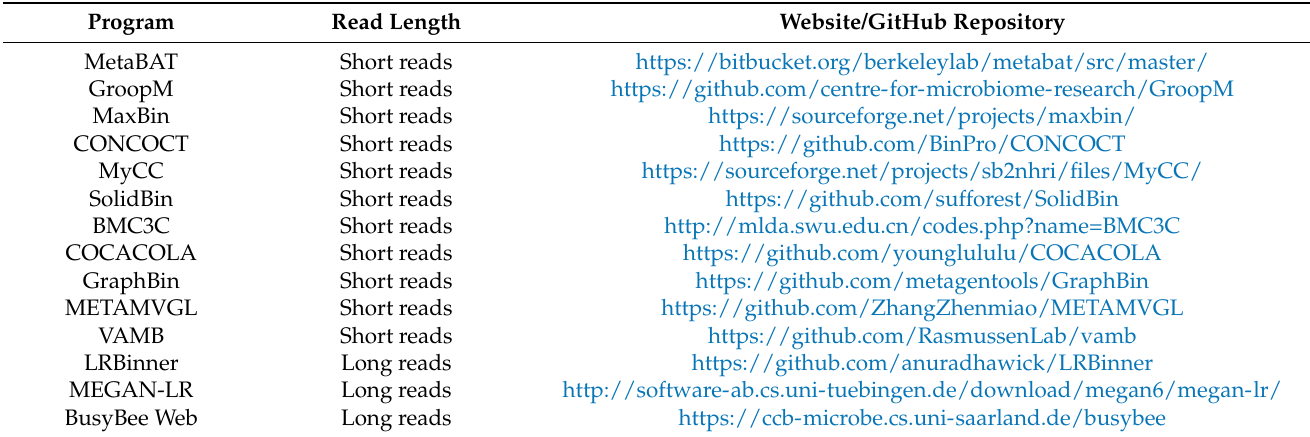
Table 7. Bioinformatic tools to perform metagenomic binning in short-read and long-read datasets or after assembly. All websites/GitHub Repository links were accessed on 23 December